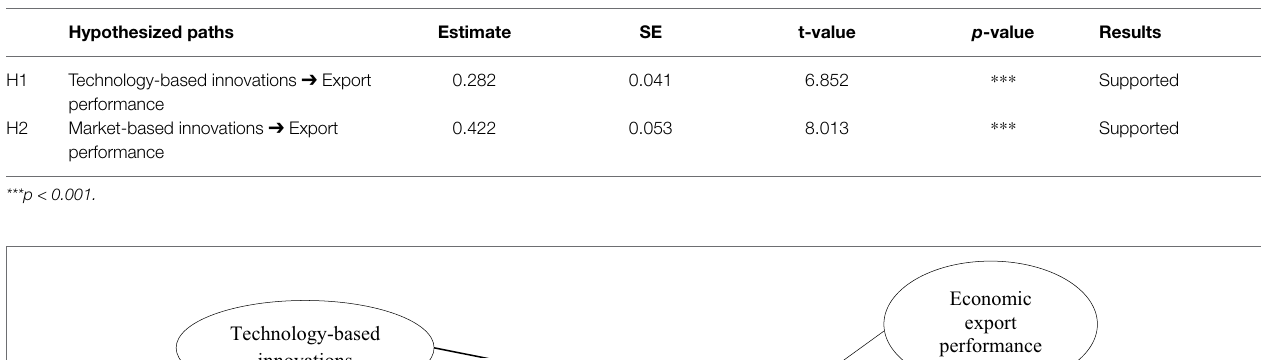
TABLE 5 | Influence of breakthrough innovations on export